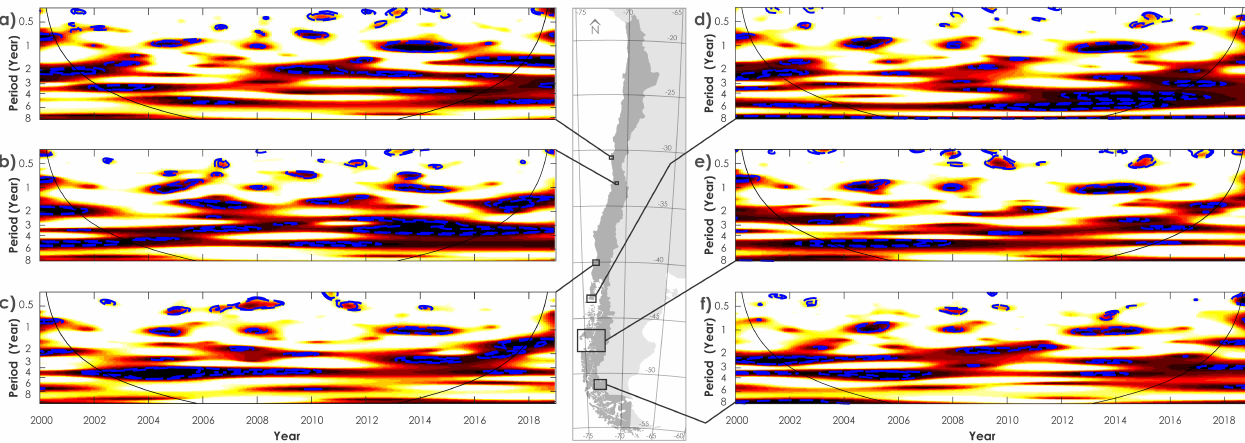
Figure 6. Wavelet coherence between the EVI and SAM temporal signal in national parks. ( a ) Fray Jorge, ( b ) La Campana, ( c ) Alerce Costero, ( d ) Tantauco, ( e ) San Rafael and ( f ) Torres del Paine. The colors are coded from yellow (low coherence) to dark red (high coherence). The dotted-dashed blue lines show the 95% and the 90% significance levels computed based on bootstrapped series. The cone of influence (black line) indicates the region not influenced by edge effects (see